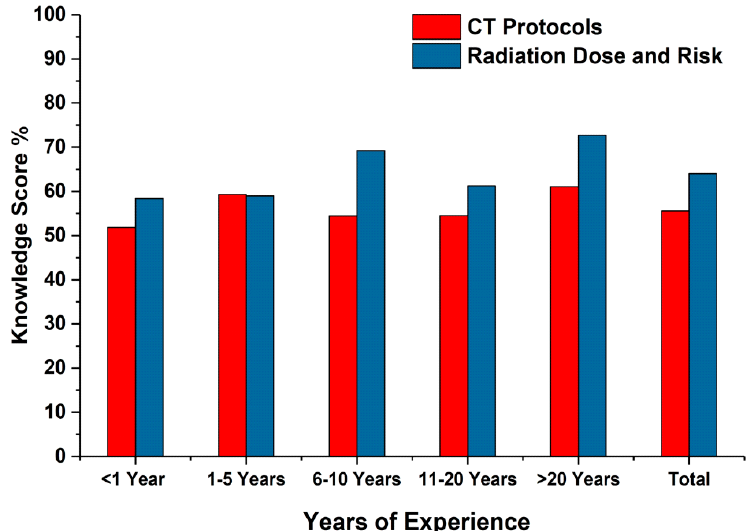
Figure4. Comparisonofparticipants’knowledgeofCTprotocolandradiationdosebasedonexperience. Figure 4. Comparison of participants’ knowledge of CT protocol and radiation dose based on experience.